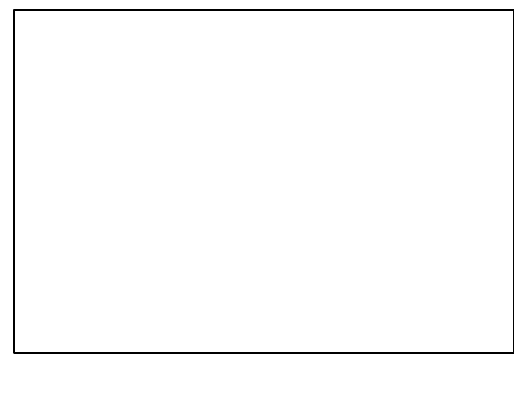
Table I : Bacterial Isolates and